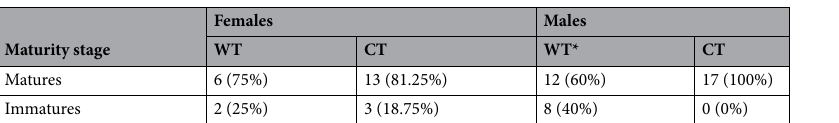
(Table 1). The morphological analysis of the sperm showed a 1.5-fold higher the percentage of abnormal cells in WT compared to CT group (59.99% and 39.56%, respectively; p = 0.03) (Fig. 4D and E). (Fig. 4G). At both 25 and 30 s, sperm motility was detected in 66.67% and 33.33% of CT males, respectively (Fig. 4F), whereas in WT group, no male showed sperm motility in any of these time points.